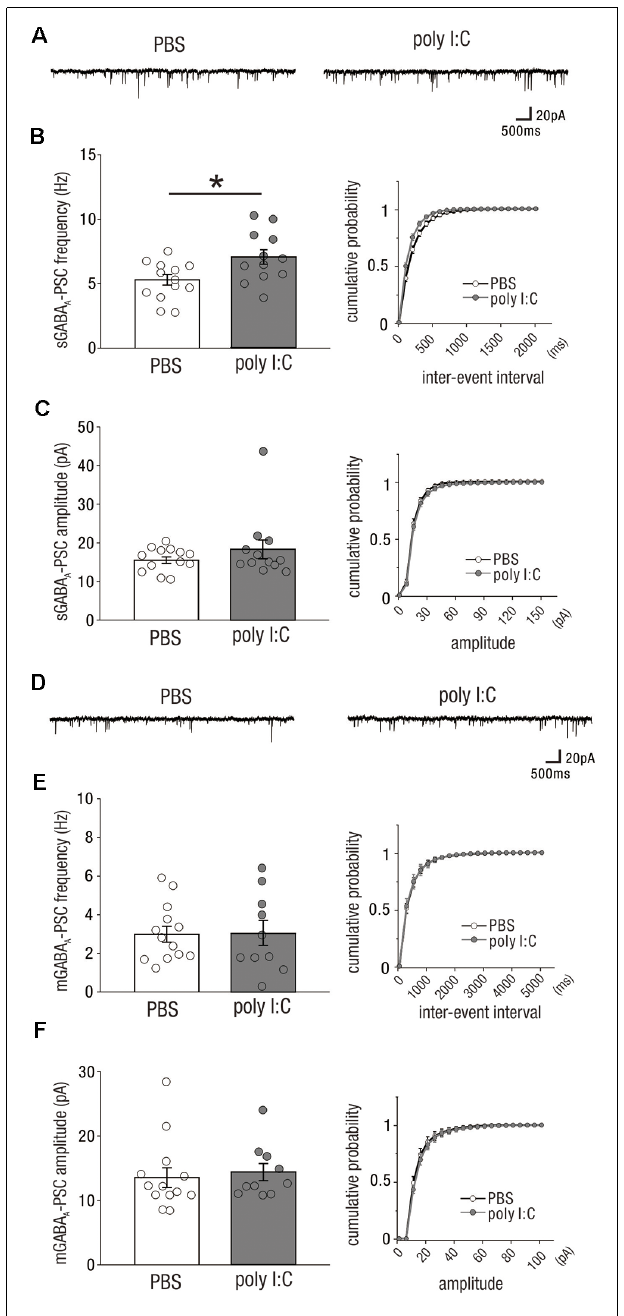
FIGURE 2 | Prenatal poly I:C treatment increases inhibitory (GABAergic) drive onto CA1 pyramidal cells in adulthood. (A) Representative data of spontaneous GABA A receptor-mediated postsynaptic currents (sGABA A -PSCs) recorded from a CA1 pyramidal cell of a PBS-treated mouse (left) and poly I:C-treated mouse (right). (B) Left: the frequency of sGABA A -PSCs of poly I:C treated-mice was significantly higher than that of PBS-treated mice. Right: cumulative probability of sGABA A -PSC frequencies shows a left-skewed curve in poly I:C-treated mice compared to that in PBS-treated mice. (C) Left: there was no significant difference in sGABA A -PSC amplitudes between PBS-treated and poly I:C-treated mice. Right: Overlapping cumulative probability curve between PBS-treated and